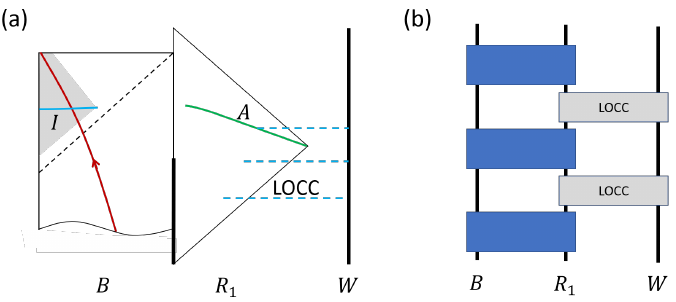
Figure 3 . (a) Illustration of the ancilla W which only couples with the rest of the bath R 1 through LOCC. (b) A quantum circuit representation of the same setup, with black hole B couples with R 1 through quantum gates, while R 1 and W are coupled only by